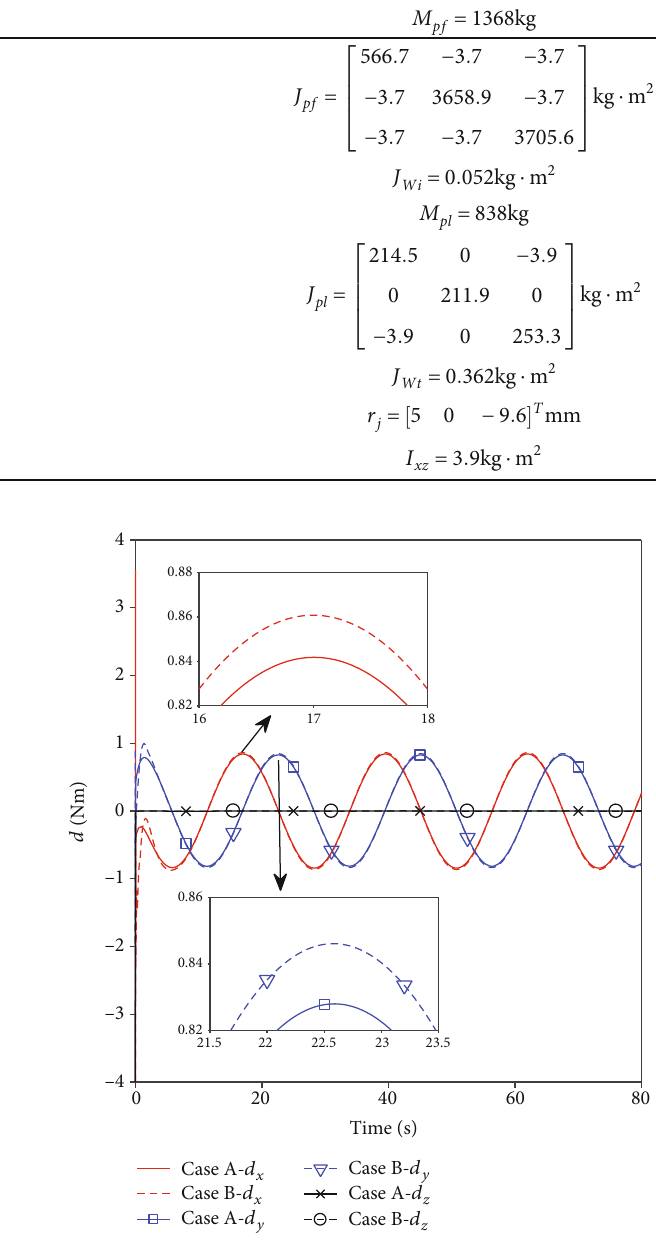
Figure 7: Simulation results of the lumped disturbance.